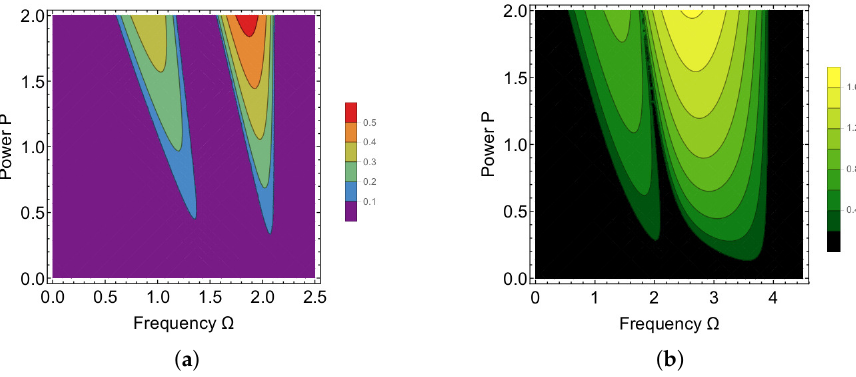
Figure 5. Contour plots showing the dependence of the MI gain on the CW power, P , in the normal-GVD regime ( σ = − 1) in the symmetric and asymmetric systems. Parameters of the symmetric system ( a ) are α = Γ = 1, η = 2, κ = 0.9 and ρ = χ = 0. For the asymmetric system ( b ), η = 0.5, α = 0.1, Γ = 2, κ = 1.1 and ρ = 0.01, χ = − 0.825 + 0.7 P .